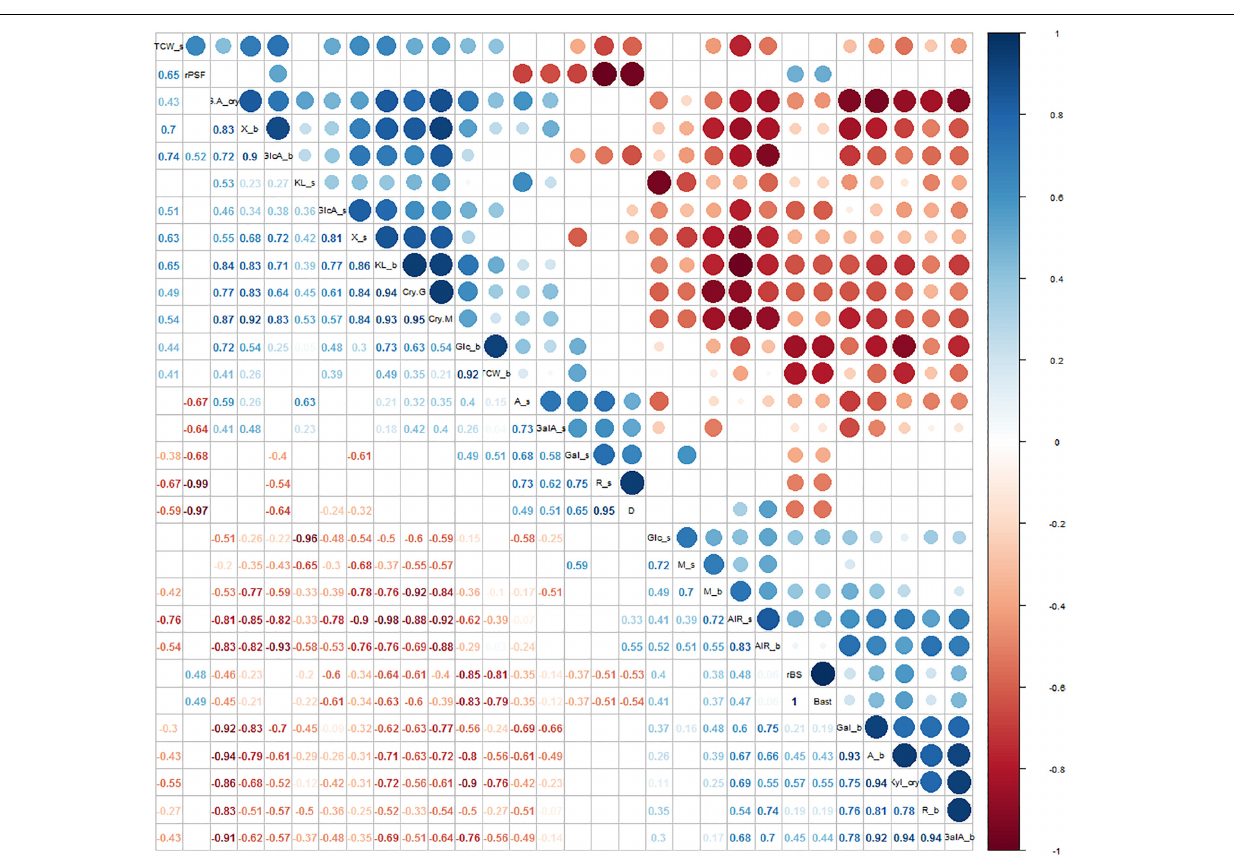
FIGURE 5 | Correlation analysis between morphological parameters and cell wall traits. Significant correlations were set at a confidence level of 0.95 and blank cells represent no significant correlations. A_s = arabinose from the stem; Gal_s = galactose from the stem; GalA_s = galacturonic acid from the stem; Glc_s = glucose from the stem; GlcA_s = glucuronic acid from the stem; M_s = mannose from the stem; R_s = rhamnose from the stem; X_s = xylose from the stem; KL_s = Klason lignin from the stem; TCW_s = total cell wall components from the stem; AIR_s = alcohol insoluble solids fraction from the stem; A_b = arabinose from the bast; Gal_b = galactose from the bast; GalA_b = galacturonic acid from the bast; Glc_b = glucose from the bast; GlcA_b = glucuronic acid from the bast; M_b = mannose from the bast; R_b = rhamnose from the bast; X_b = xylose from the bast; KL_b = Klason lignin from the bast; TCW_b = total cell wall components from the bast; AIR_b = alcohol insoluble solids fraction from the bast; CryG = percentage of crystalline cellulose; CryM = percentage of crystalline mannan; GA_cry = percentage of galacturonic acid in the crystalline cell wall fraction; Xyl_cry = percentage of xylose in the crystalline cell wall fraction; D = diameter; rBS = ratio between bast and WHC; Bast = area of bast; rPSF = ratio between primary bast and secondary bast